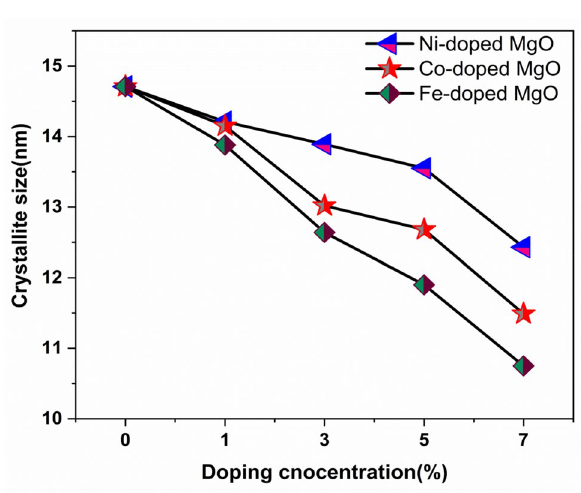
Figure 4. The correlation between the doping ratio and crystallite size of divalent metal ions (Ni, Co, and Fe) doped MgO